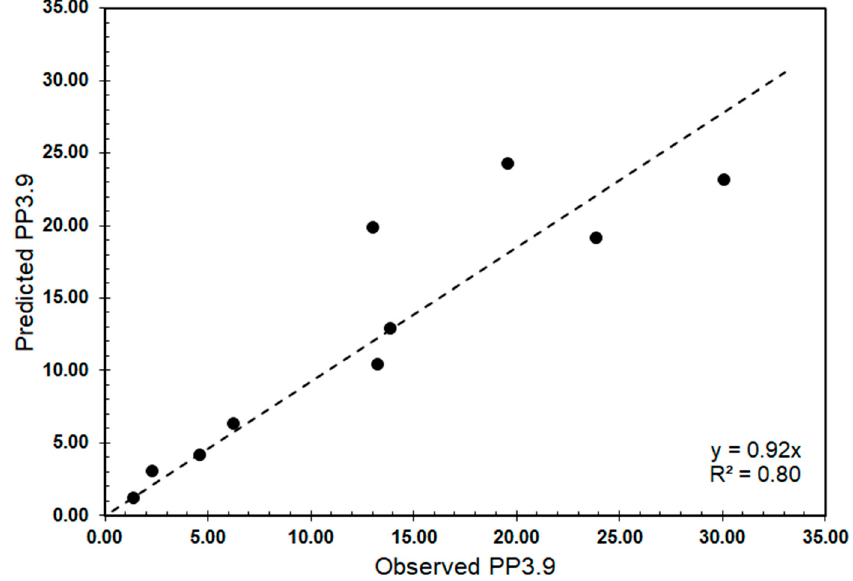
Figure 11. Comparison of %pp3.9 estimated from the spectra of froth with %pp3.9 measured from froth solids. The dashed line represents the trend line.